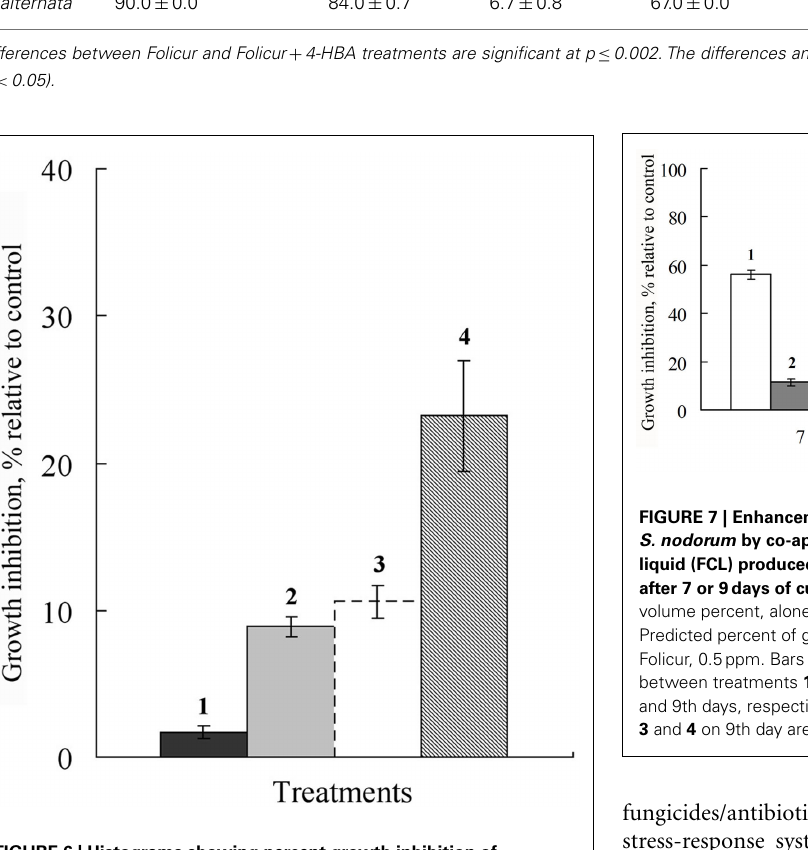
Dubeyetal.,2011;PretoriusandvanderWatt,2011;Shcherbakova,